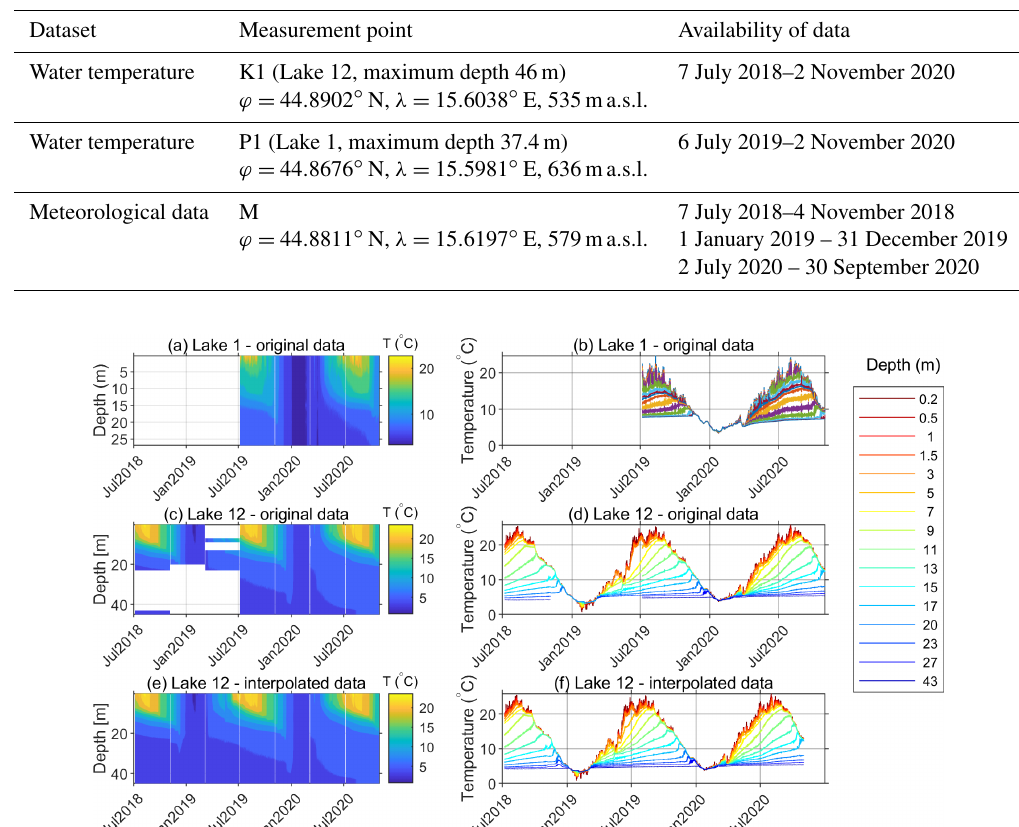
Figure 2. Measured water temperatures in Lake 1 ( a and b ) and Lake 12 ( c and d ) and water temperature in Lake 12 after interpolation of the measured data ( e and f